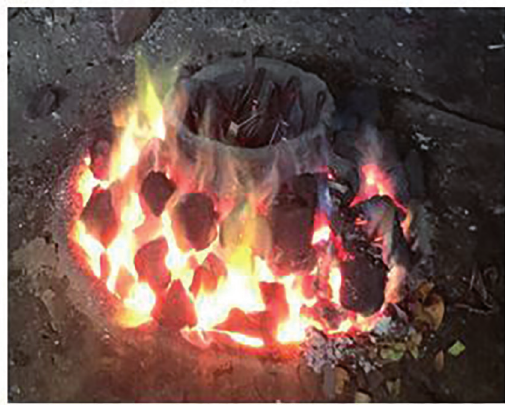
Figure 1: Casting furnace.